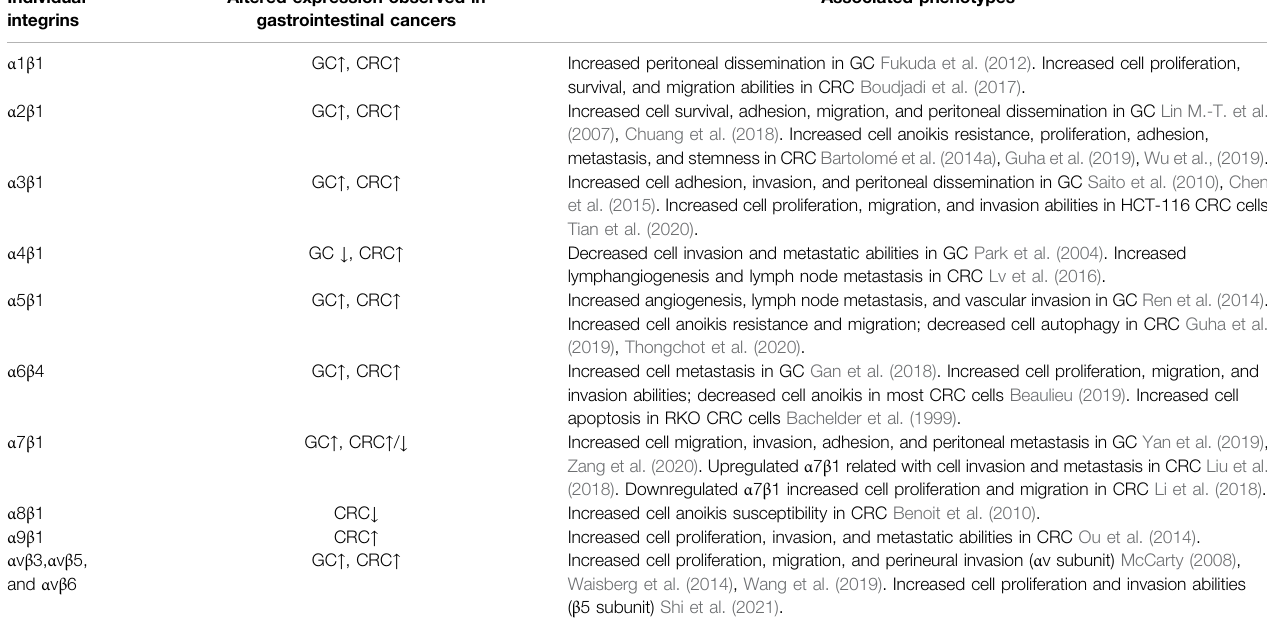
TABLE 1 | Aberrant expression of integrins in gastrointestinal cancer. Individual